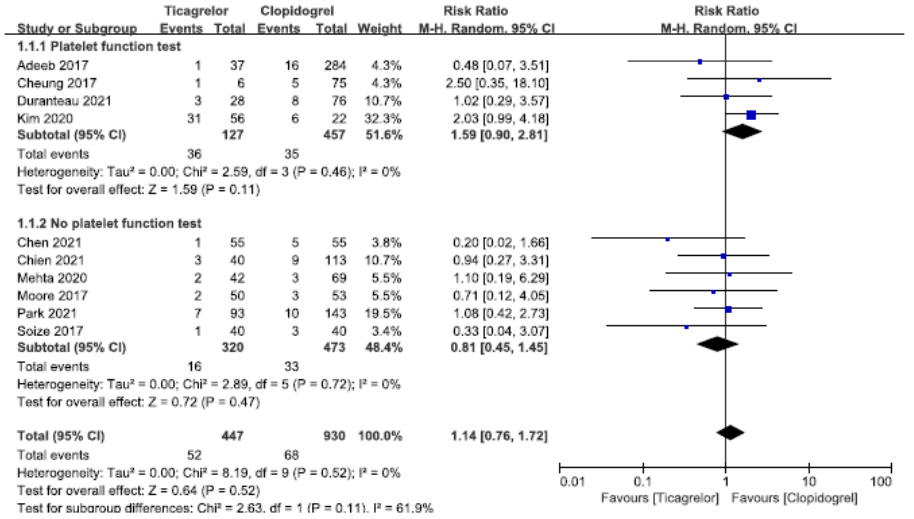
Figure 3. Forest plots of the meta-analysis comparing thromboembolic complications between ticagrelor and clopidogrel treatment. Top, the studies with platelet function test, and the subgroup analysis for the patients with clopidogrel resistance study. Bottom, the studies with no platelet function test.